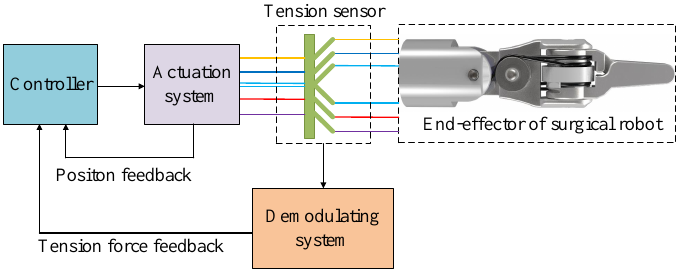
Figure 2. The scheme of typical cable-driven end-effector in laparoscope surgical